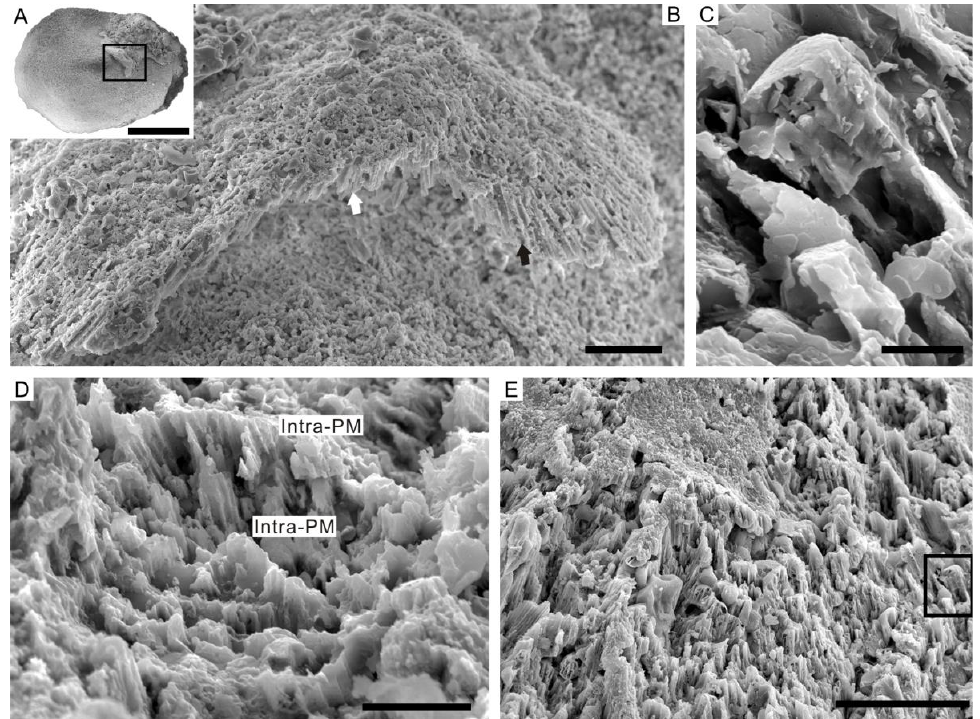
Figure 5. Regularly oriented simple prismatic microstructure of early Cambrian Postacanthella shells. ( A ) Specimen NRM Mo196856, overall morphology of cap-shaped Postacanthella , preserved as phos- phatic internal mold. ( B ) Specimen NRM Mo196857, shell remnants showing the regularly oriented mineral prisms of the ROSP form. ( C ) Amplification of ( E ), showing individual prisms. ( D ) Specimen NRM Mo196858, phosphatized organic remnants interpreted as the inter- and intra-prismatic organic matrix. ( E ) Specimen NRM Mo196859, mineral prisms are highly inclined or perpendicular to shell surface. Scale bars: 500 μm ( A ), 20 μm ( B , E ), 5 μm ( D ), and 2 μm ( C ). The IOCP microstructure is characterized by irregularly oriented calcitic prisms. Co-